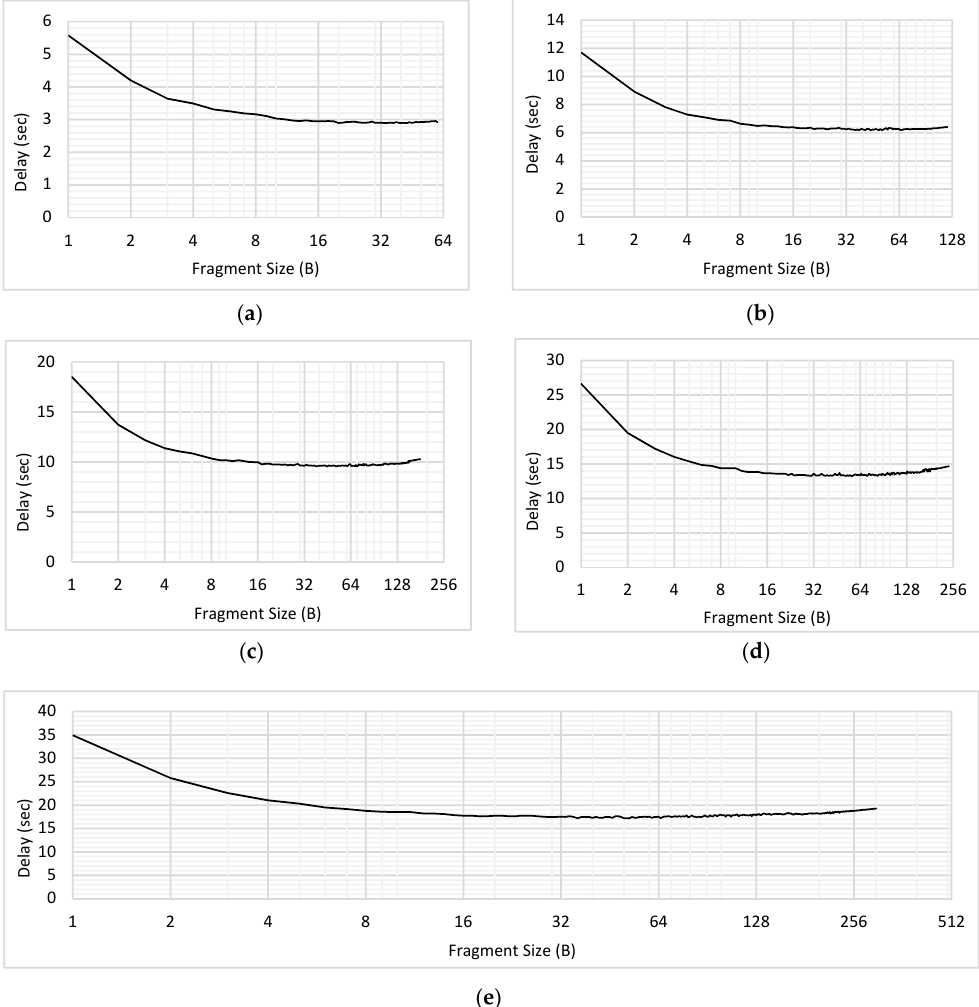
Figure 14. Influence of Varying Fragment Size for Low Priority (CBR) Traffic. ( a ) Packet Size = 60B; ( b ) Packet Size = 120B; ( c ) Packet Size = 180B; ( d ) Packet Size = 240B; ( e ) Packet Size = 300B.